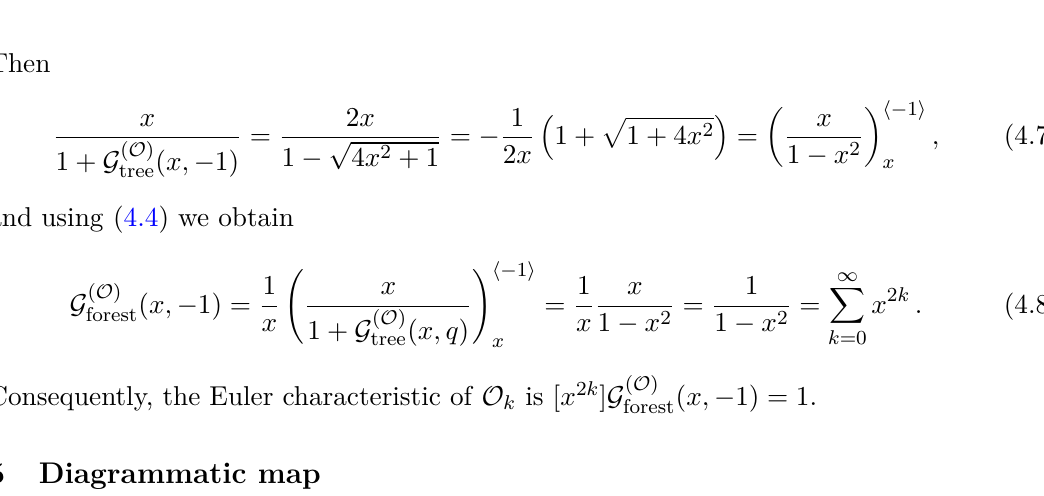
Table 2 . The f -vector and Euler characteristic χ of O k for k ≤ 7